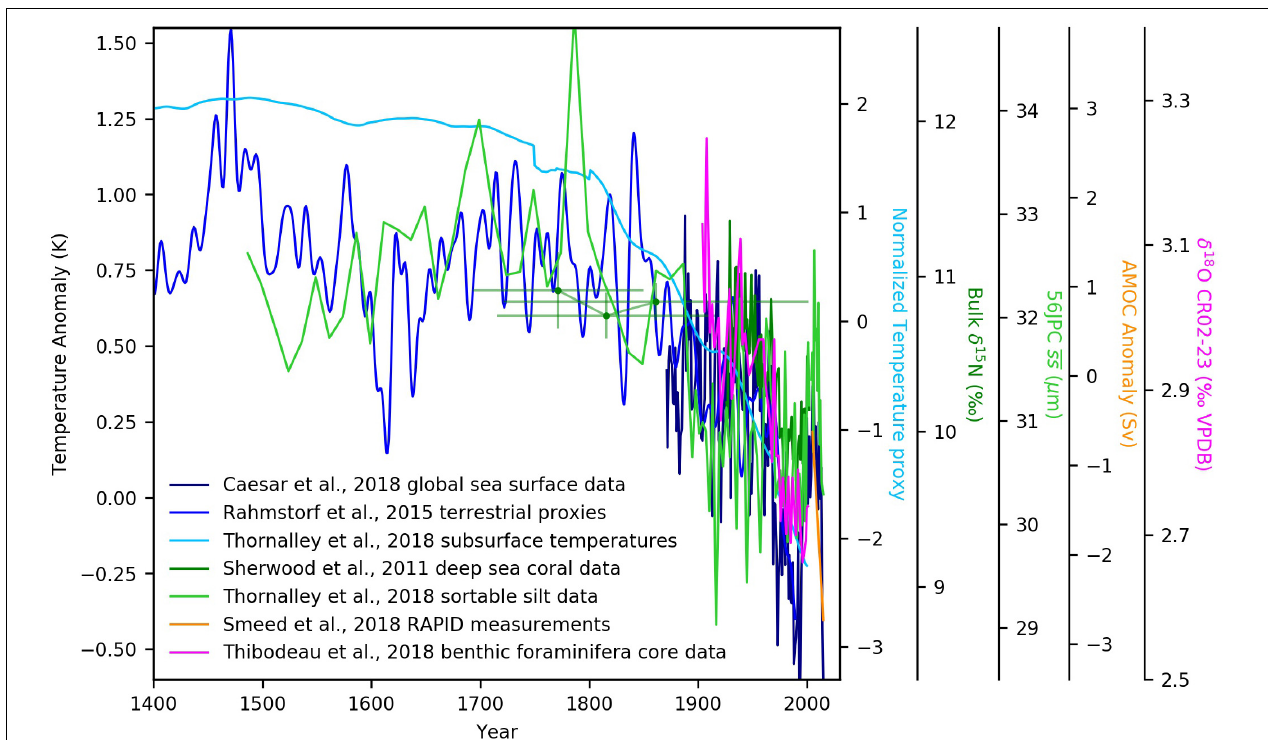
FIGURE 9 | Trend of the strength of the overturning circulation (AMOC) in observations since 1400 from various proxies. Shown are (i) the long-term evolution of the sea surface and land temperatures in the North Atlantic region (different shades of blue; Rahmstorf et al., 2015; Caesar et al., 2018; Thornalley et al., 2018), (ii) the long-term evolution of the ocean heat content of the Atlantic (red, Zanna et al., 2019), (iii) the long-term evolution using data from deep sea cores [light green (Thornalley et al., 2018), dark green (Sherwood et al., 2011), and magenta (Thibodeau et al., 2018)] and (iv) the linear trend of in situ AMOC monitoring by the RAPID project (orange, Smeed et al.,